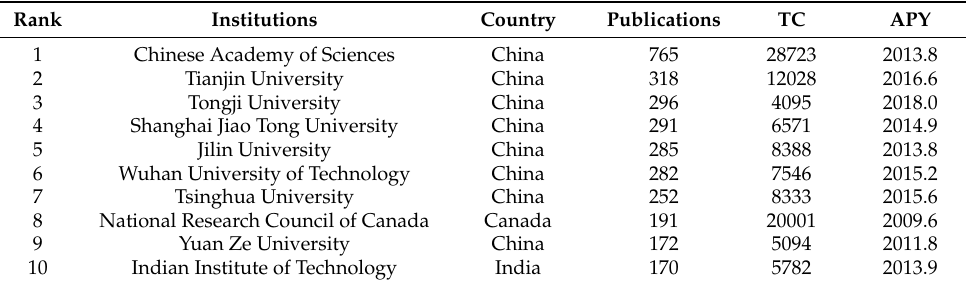
Table 5. Information summary of the top 10